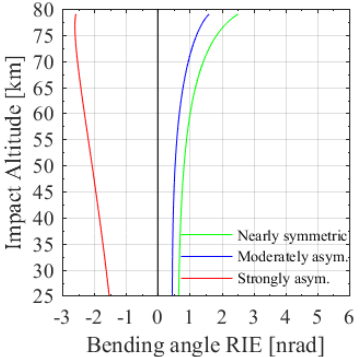
Figure 8. Di ff erence profiles of the mean bi-local Ne 2 term and modeled Kappa bending angle RIEs (i.e., mean bi-local Ne 2 minus mean modeled Kappa) for the classified nearly symmetric ( green line ), moderately asymmetric ( blue line ), and strongly asymmetric ( red line ) data sets, as illustrated in Figure 7.